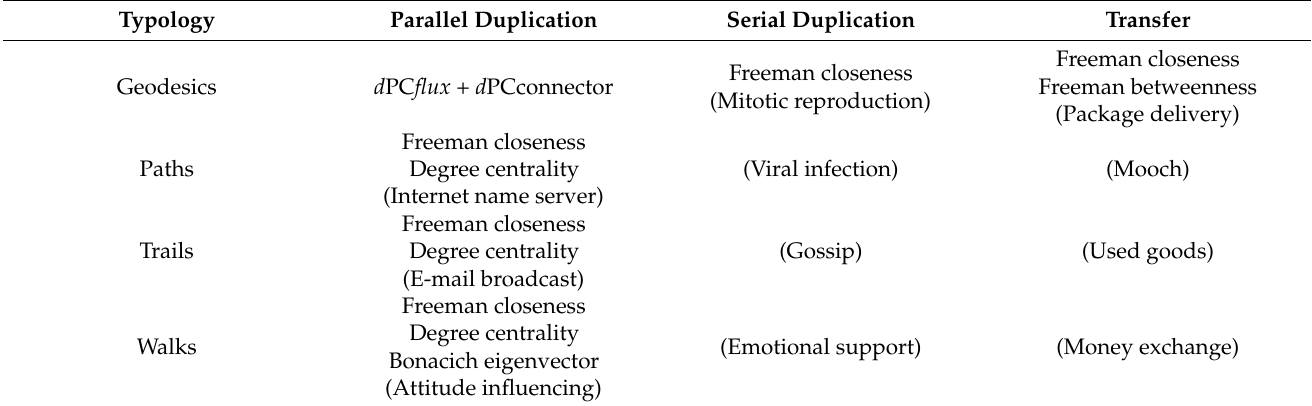
Table 3. Typology of flow processes and major centrality measures (adapted from [81]). Met- rics combining a particular flow propagation trajectory and node-to-node transmission are shown. As an example, a process that shows the particular combination of flow characteristics is given within